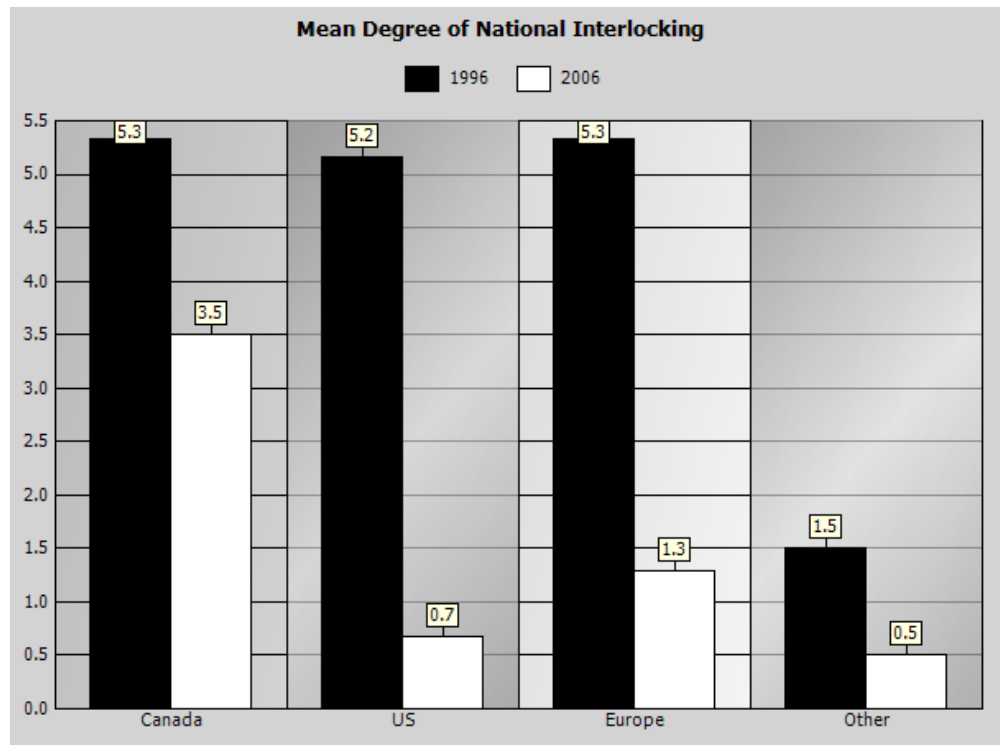
Figure 3. Mean Degree of National Interlocking for Categories of Country of Control, Nationally-Bound Companies, 1996 and